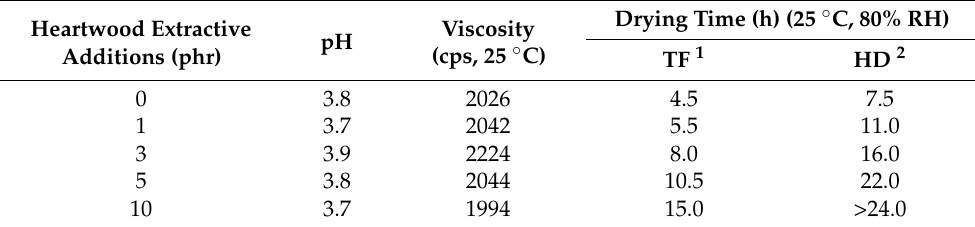
Table 2. Coating properties of ROL with various heartwood extractive additions.